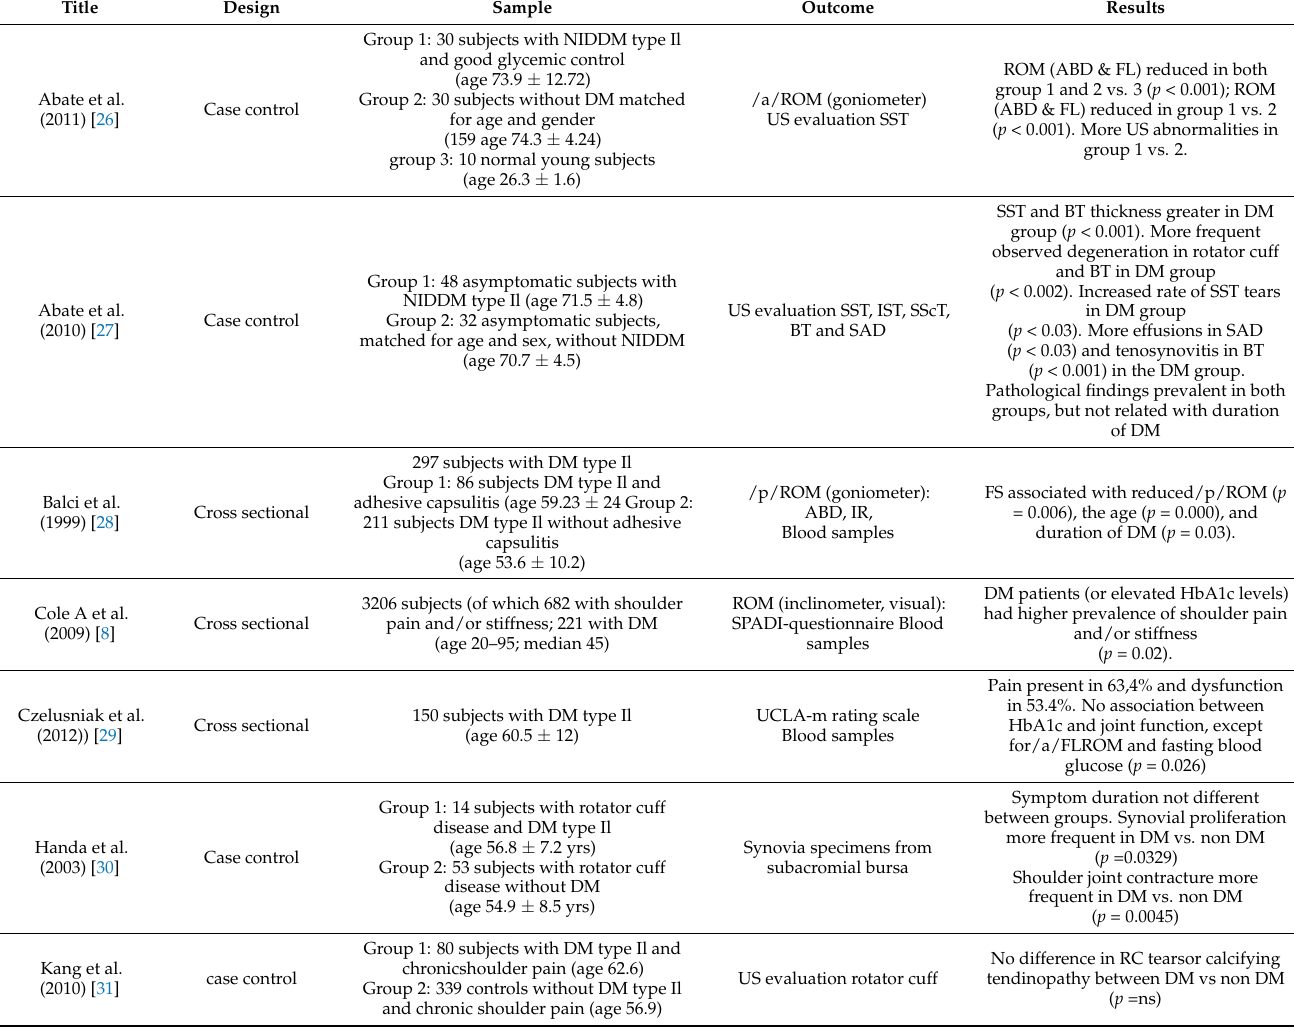
Table 1. Characteristics of the selected